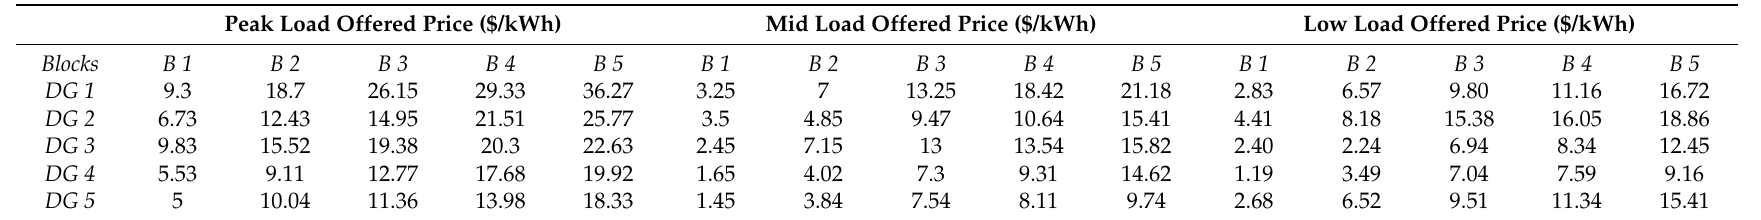
Table 2. Data of DGs’ offered price blocks for active power.